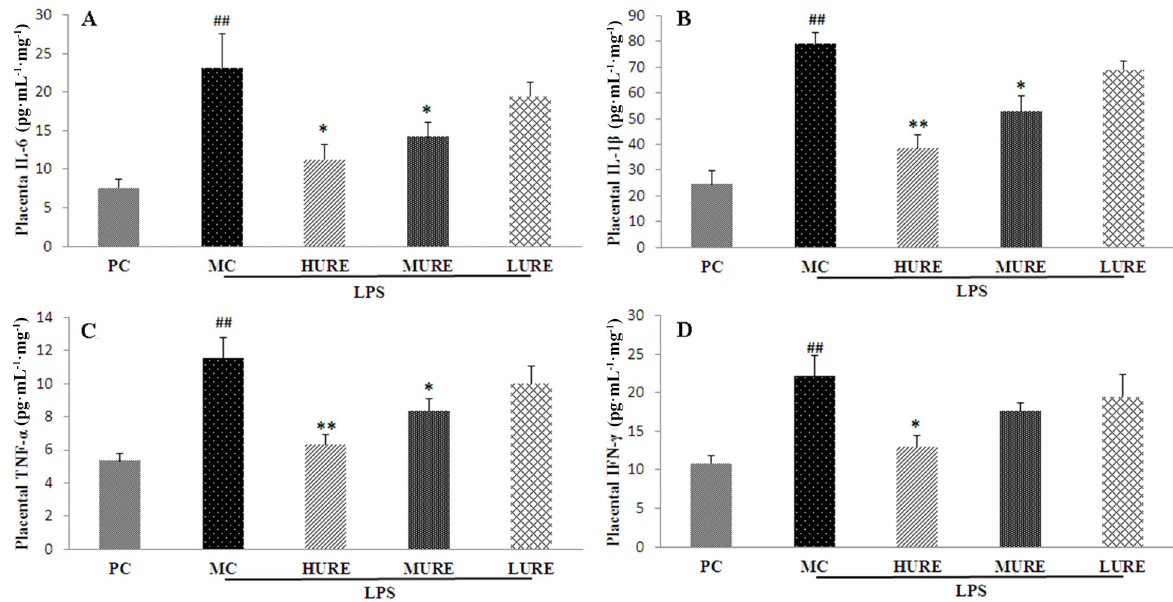
Figure 6. Placental levels of in fl ammatory cytokines in different groups on gestational day 20. Placental levels of interleukin IL-6 ( A ), IL1- b ( B ), tumor necrosis factor (TNF)- a ( C ), and interferon (IFN)- g ( D ) were signi fi cantly higher in the MC group and lower in the Uncaria rhynchophylla alkaloid extract (URE) group. Data are reported as means ± SE (n=8/group). ## P o 0.01 vs PC group, *P o 0.05 and **P o 0.01 vs MC group (ANOVA). PC: pregnant control group; MC: LPS-treated group; HURE: LPS plus high-dose URE; MURE: LPS plus medium-dose URE; LURE: LPS plus low-dose